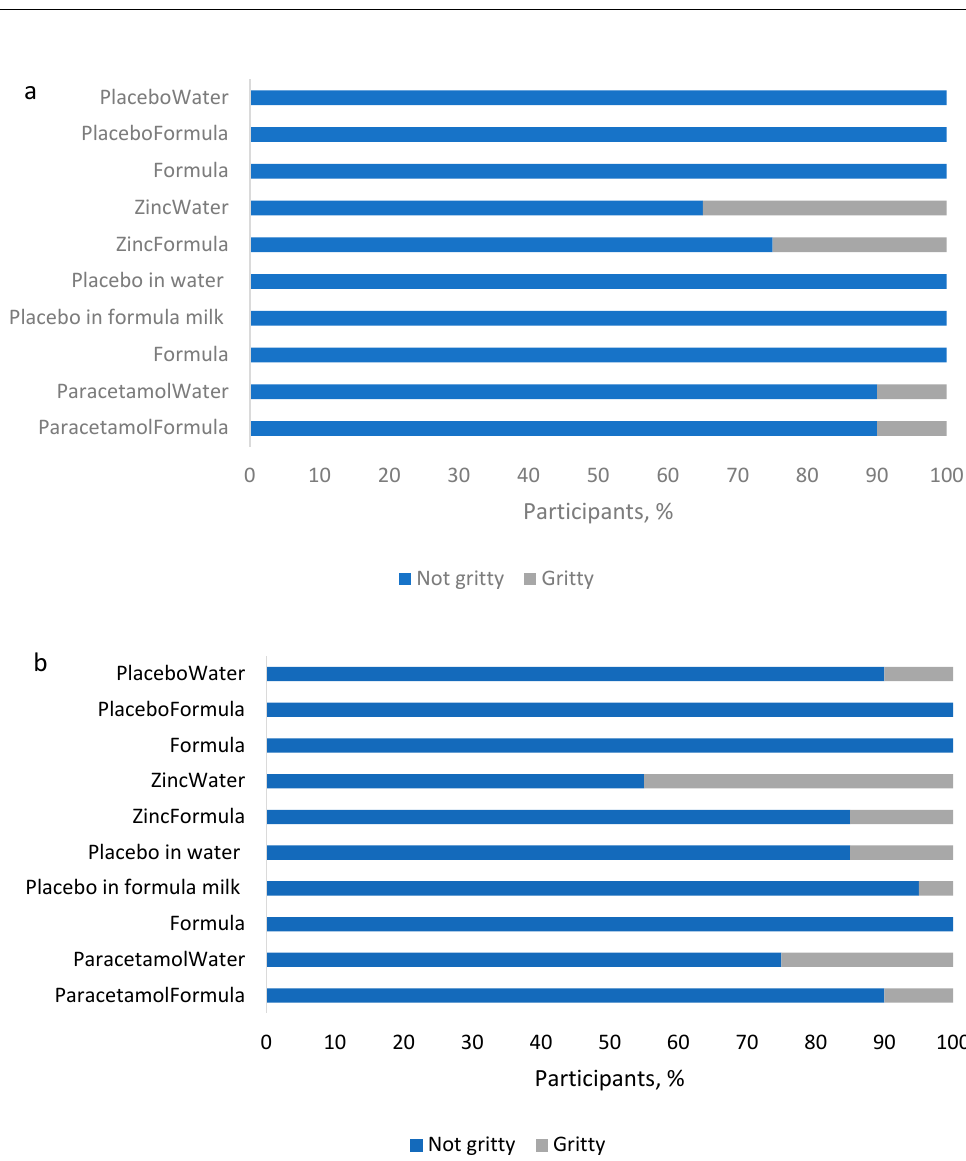
Figure 2. Grittiness of samples in the two platform formulations: ( a ) T1 (lactose), and ( b ) T2 (mannitol). Platforms differed in terms of perceived grittiness of samples, with more of the mannitol-based samples assessed as gritty (70%, 7/10) compared to the lactose-based samples (40%, 4/10). While the mannitol-based samples assessed as gritty included place- bos without APIs, the lactose-based samples rated gritty were only those with included APIs. However, with mannitol, only a maximum of three volunteers found the placebo dispersion in water to be